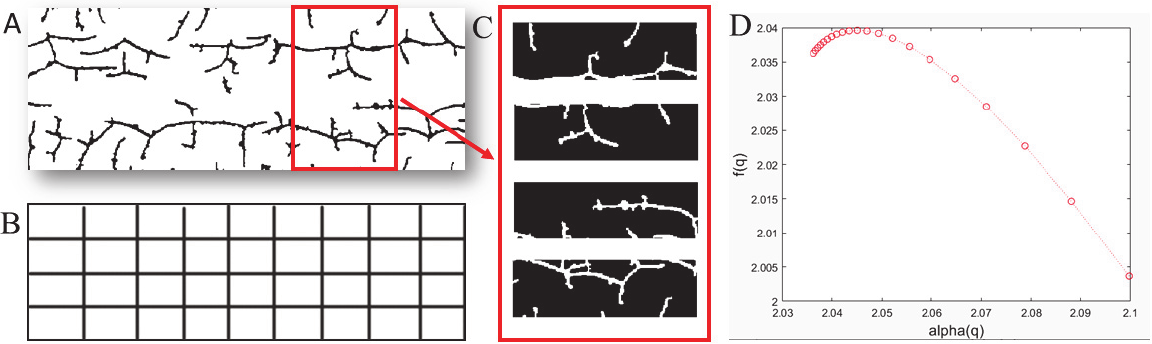
Figure 1. Schematic representation of the multifractal characterizations of the crack propagation: ( A ) pre-processing of the original crack image, ( B , C ) dividing cracked images, and ( D ) calculating crack multifractal spectra.